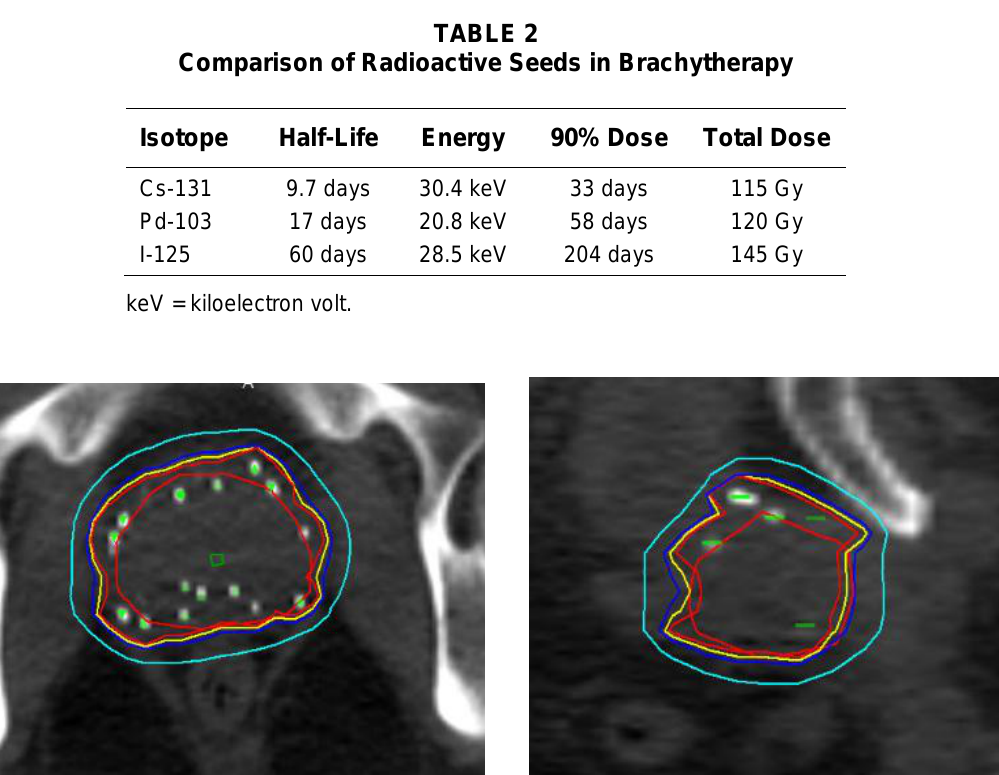
FIGURE 2 . Axial and sagittal views, representing the 100% (red), 90% (yellow), 80% (blue), and 50% (aqua) isodose lines of a man treated with brachytherapy to the prostate to a total dose of 144 Gy. The clinical target volume, consisting of the prostate, is outlined in